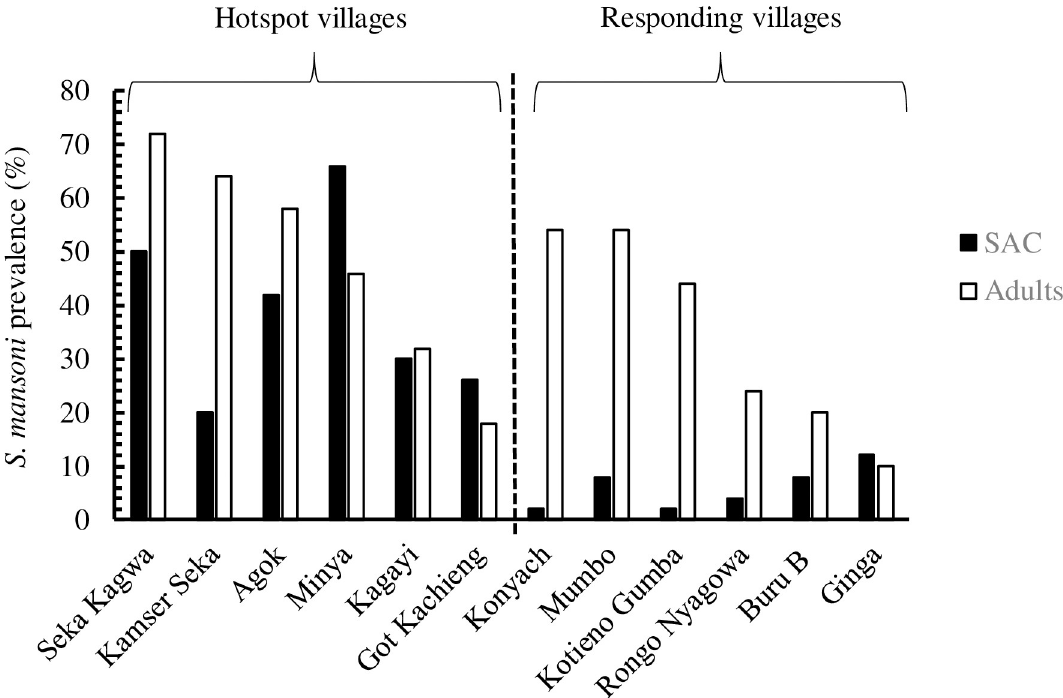
Fig 2. The prevalence of Schistosoma mansoni in PHS and R villages by age group (SAC age; adults age, in 2018).